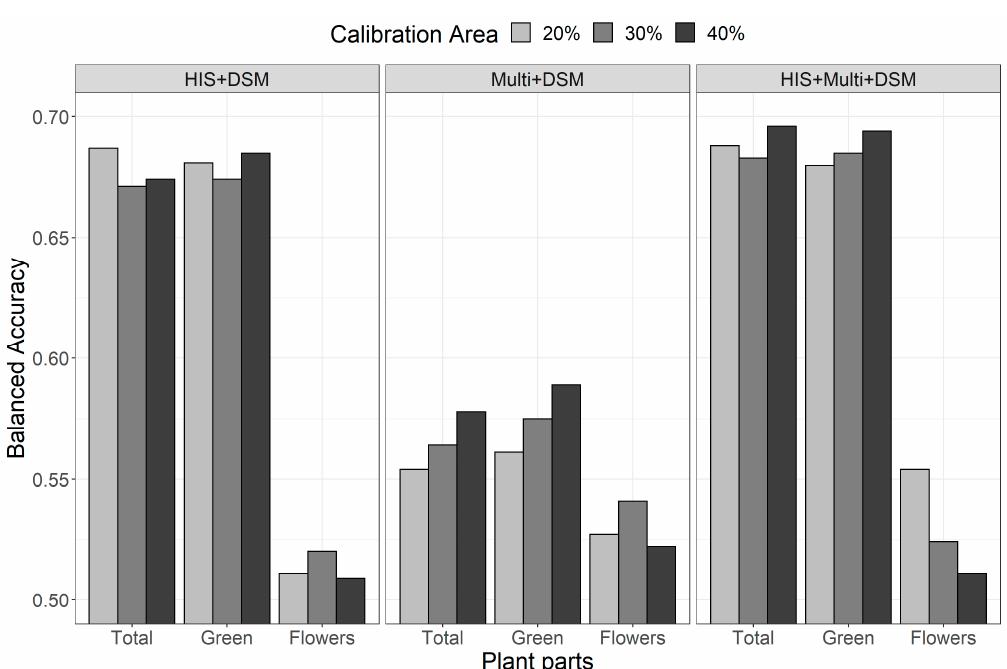
Figure 5. Outcomes of the assessment of the 27 models expressed as balanced accuracy (BA). Table 1. Results of the linear model using balanced accuracy (BA) as the response variable and the dataset factors of variable ( Set ), plant part ( Part ) and percentage of calibration area ( Cal. Area ) as covariates. Values are reported as mean estimate and 95% confidence interval. Only the interactions between the factors that were found to significantly affect BA are shown. The reference levels are HIS + DSM for Set , Total for Part and 30% for Cal. Area . Significance is reported as *** p < 0.001. Mean 95%